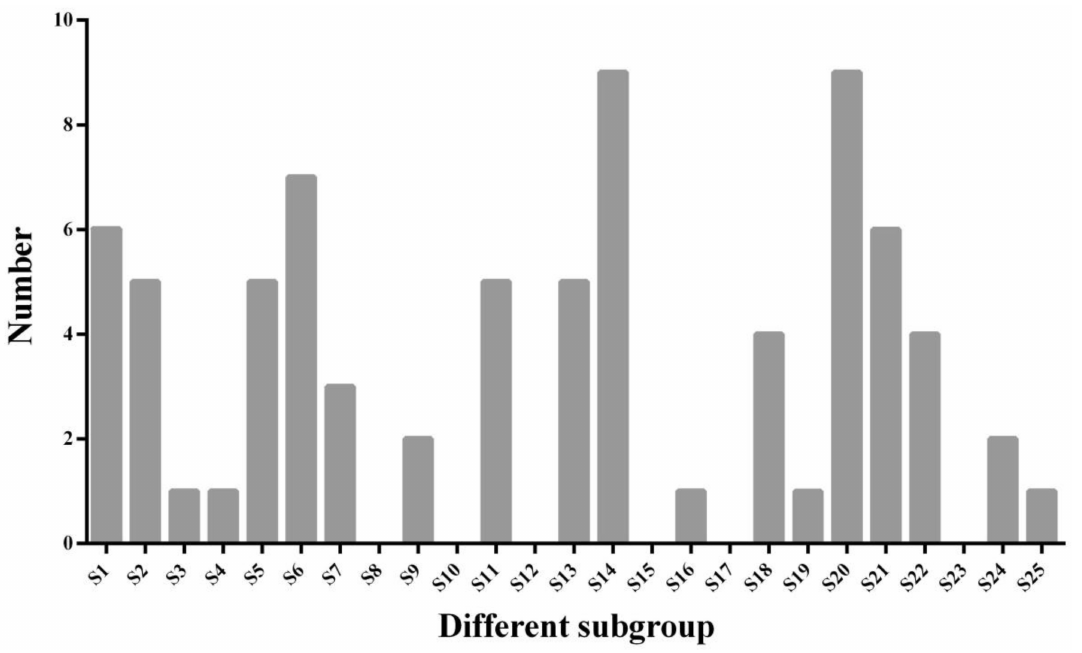
Figure 3. Distribution of carrot R2R3-MYB TFs subfamilies. R2R3-MYB TFs subfamilies represented on the Abscissa. Ordinate represents the number of each subfamily